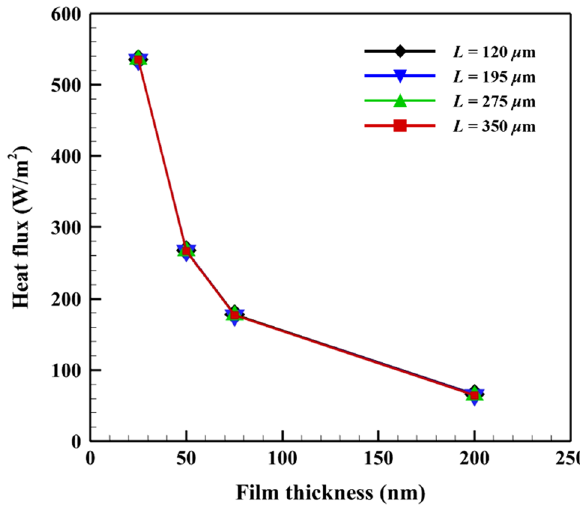
Figure 5. Heat flux of the SPhPs for various film lengths and thicknesses.